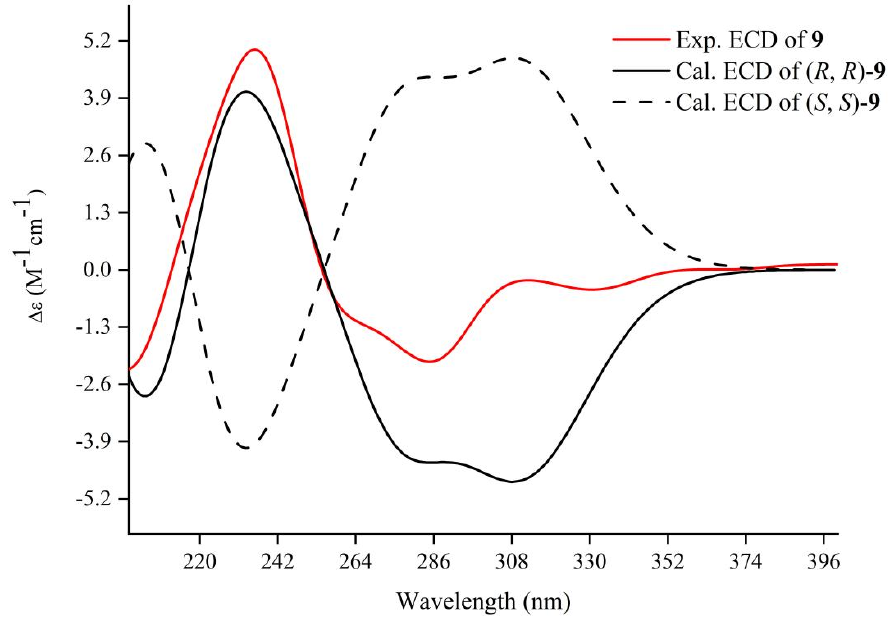
Figure 8. Experimental ECD spectra (200–400 nm) of 9 in methanol and the calculated ECD spectra of the model molecules of 9 at the PBE0/def2-TZVP level.